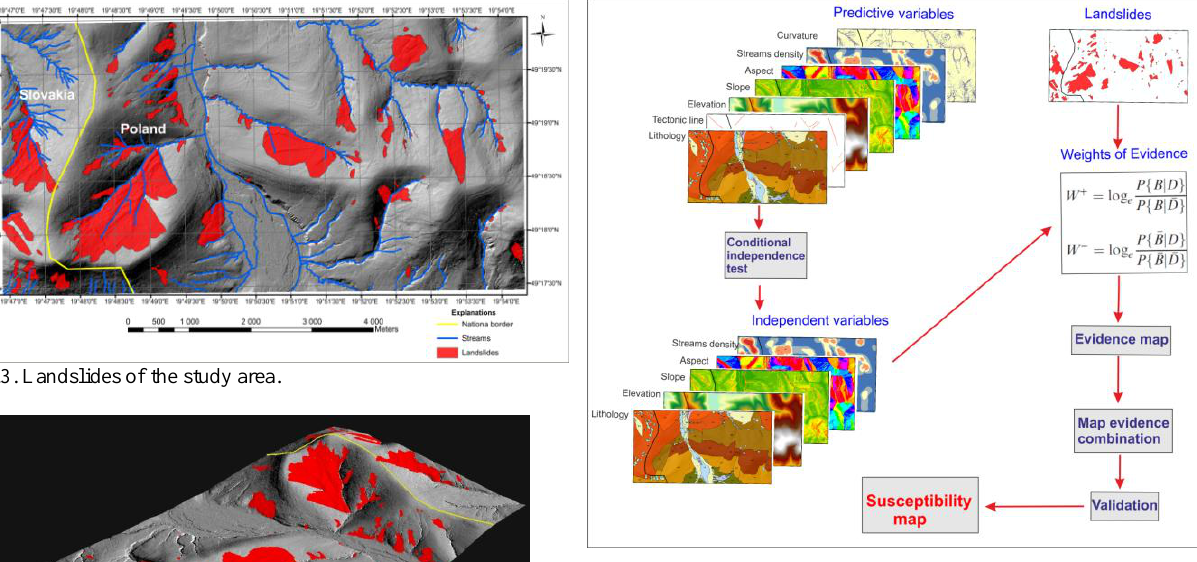
Fig.4. Flow diagram for landslide susceptibility